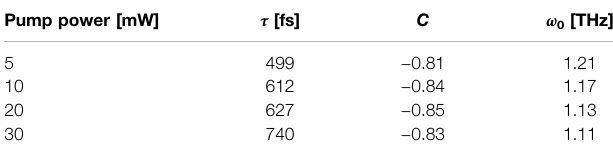
TABLE 1 | Fitting parameters used in Figure 5